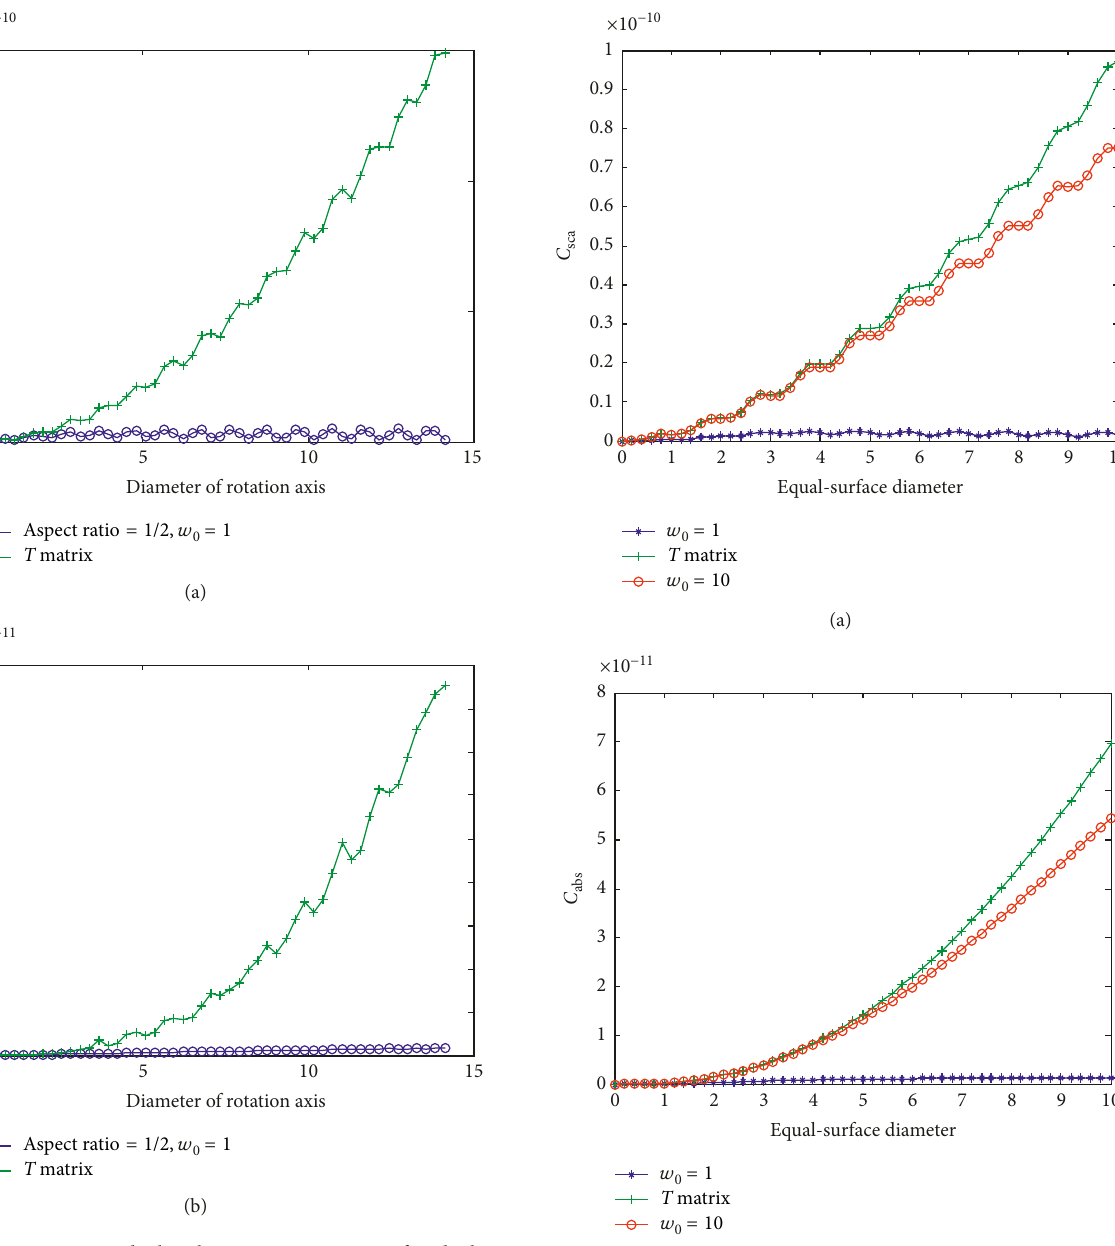
1/2, λ 0.5, m 1.7 +0.001 i ). (cid:31) (cid:31) (cid:31)